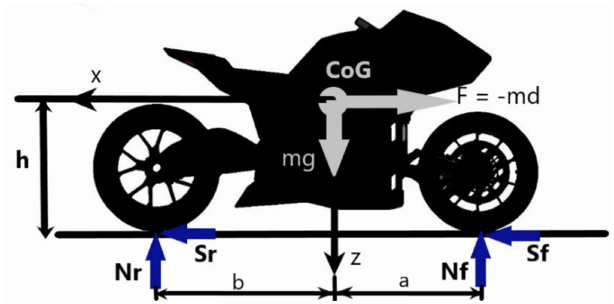
Figure 1. Simple motorcycle model of acting forces during